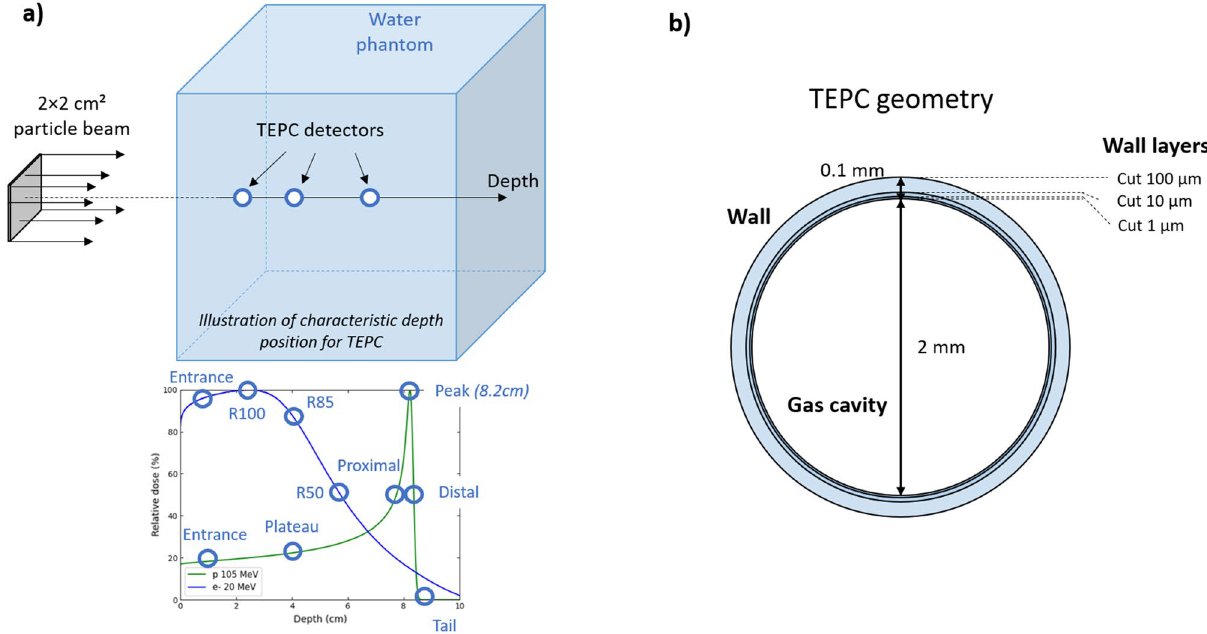
Figure 1. Illustration of ( a ) simulation geometry of particle beam sent in a water phantom and TEPC actors positioned at characteristics depth, and ( b ) geometry of the TEPC detector and cuts applied to each wall